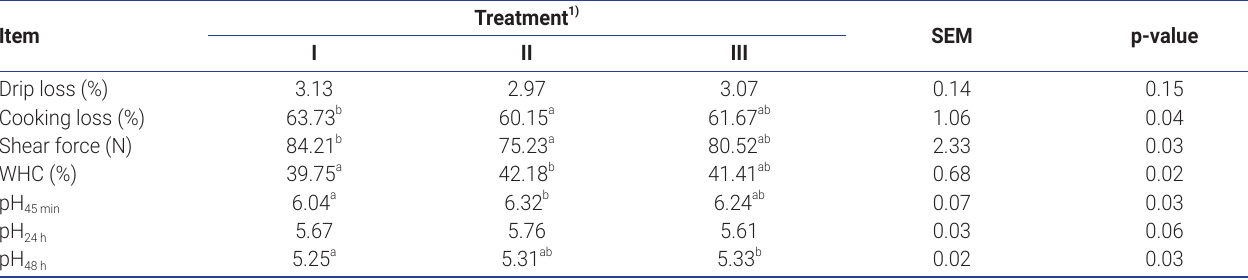
Table 5. Effect of dietary GAA and RPM supplementation on meat quality of lambs